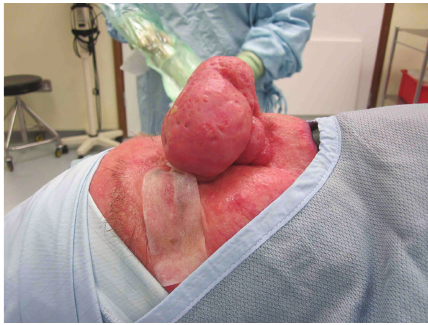
Figure 5: Case 3, intraoperative lateral.